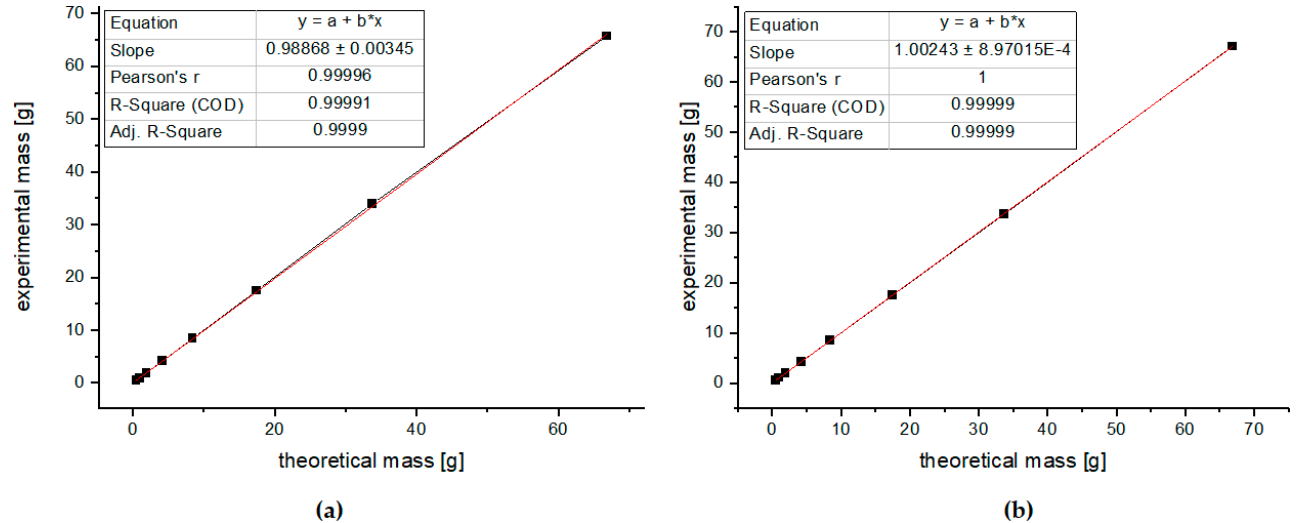
Figure 6. Linearity of the method ( a ) with repetition time of 6 s and ( b ) with repetition time of 8.5 s.